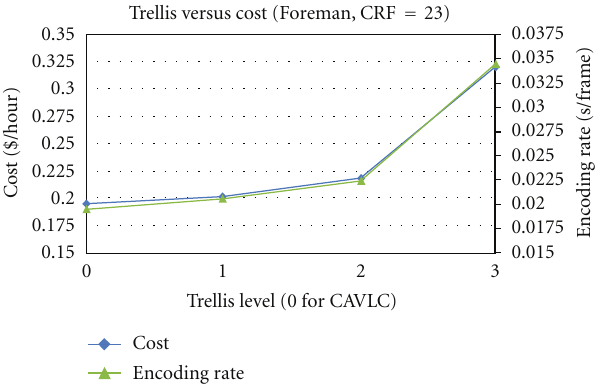
Figure 14: Encoding cost and rate with varying Trellis levels (Foreman, crf = 23).